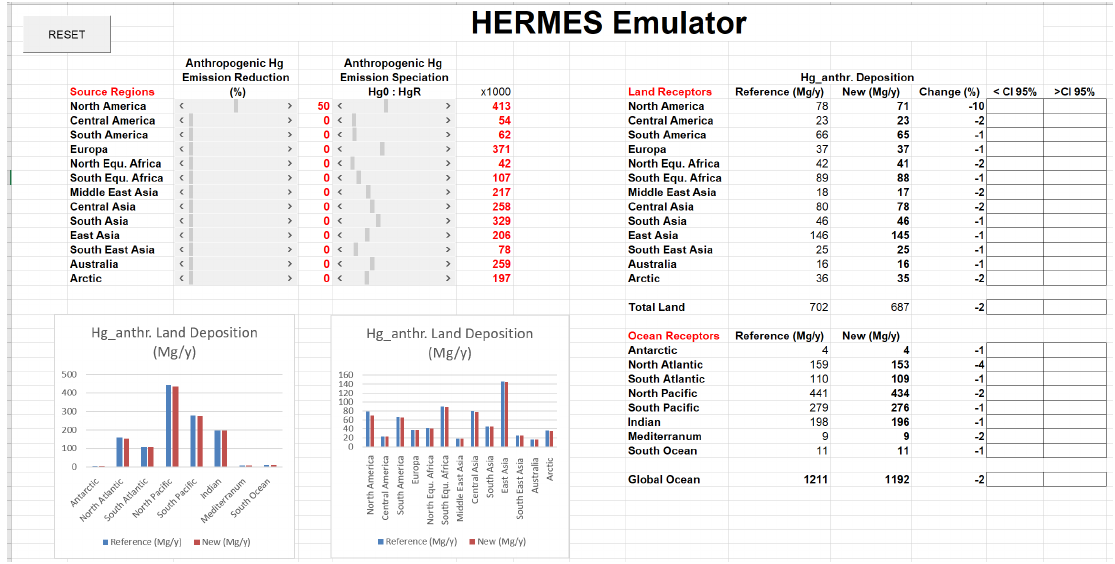
Figure 6. Use-case 4: Hg emission reduction by 50% in North anthr